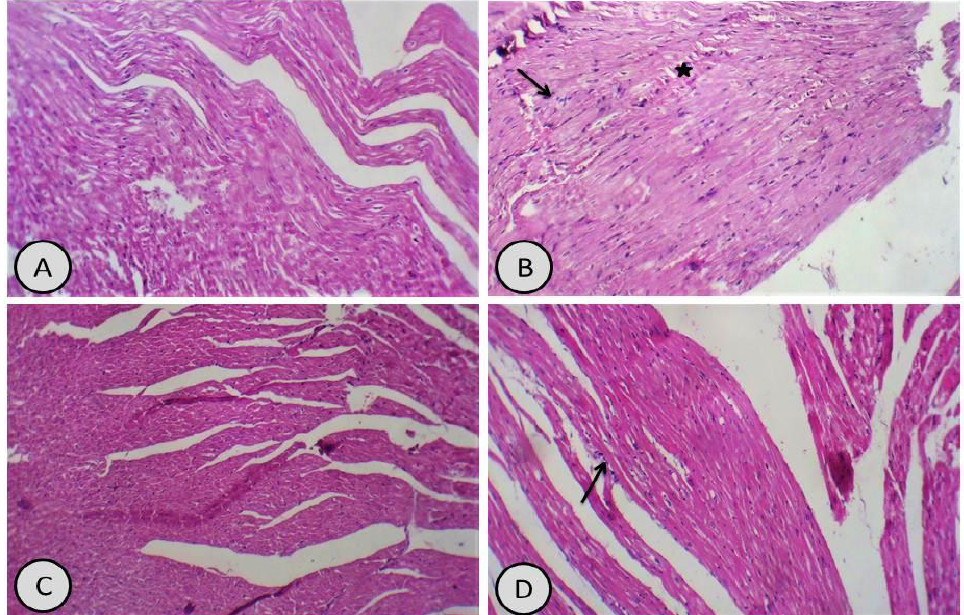
Figure 6. Photomicrographs of heart sections: ( A ) control group showed normal cardiac muscles and fibres (H&E × 400); ( B ) CdCl 2 group showed interstitial inflammatory cells (arrow) and muscle fibre disruption with interstitial haemorrhage ( * ) (H&E × 400); ( C ) R. damascena group showed normal cardiac muscle fibres (H&E × 400); ( D ) group treated with R. damascena in combination with CdCl 2 showed restoration of cardiac muscle structure with appearance of interstitial inflammation (thin arrow) H&E×400).